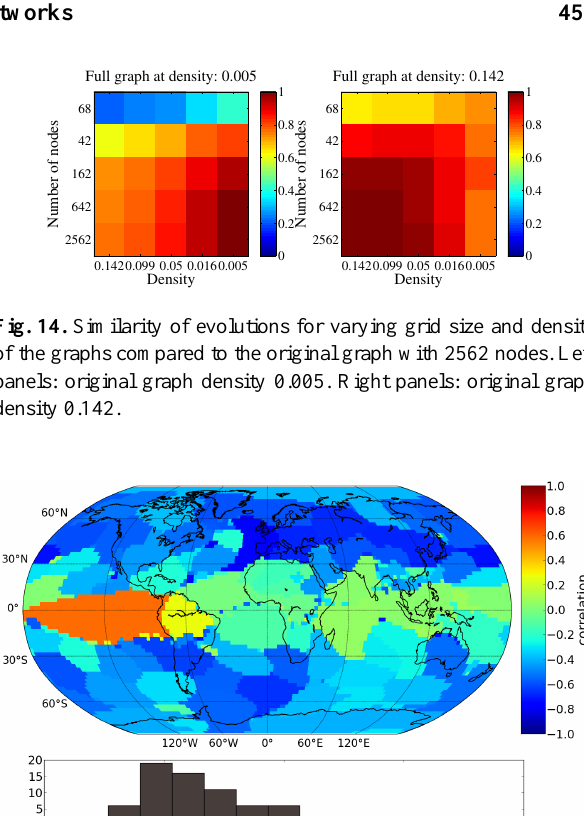
Fig. 12. Evolution of the graph-theoretical properties of the tropics subgraph.